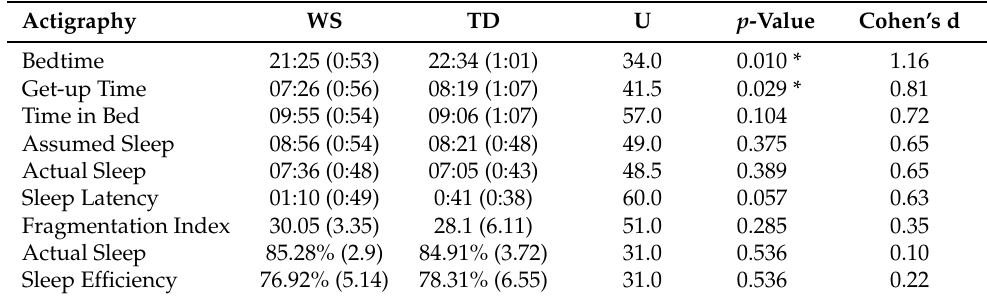
Table 4. Group mean scores, standard deviations, and group differences in